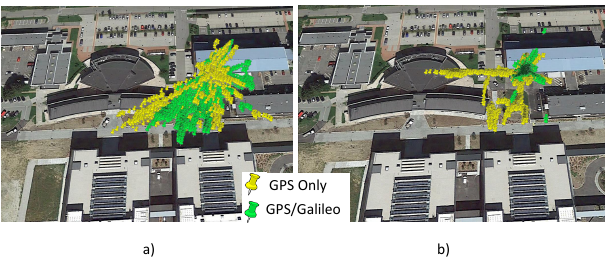
Figure 13. Horizontal position solutions computed using the configurations analyzed. ( a ) Position solutions computed using the configurations without RAIM; ( b ) position solutions computed using the configurations with RAIM.